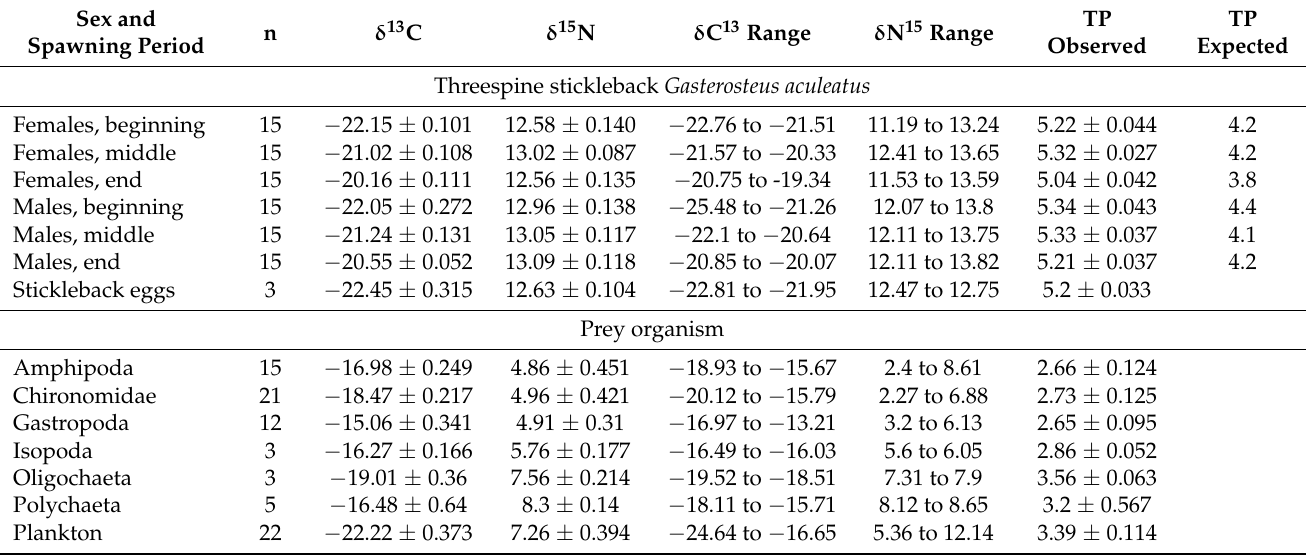
Table 3. Values and ranges of δ 13 C and δ 15 N and trophic position (TP, mean ± SE) in males, females, and eggs of Gasterosteus aculeatus